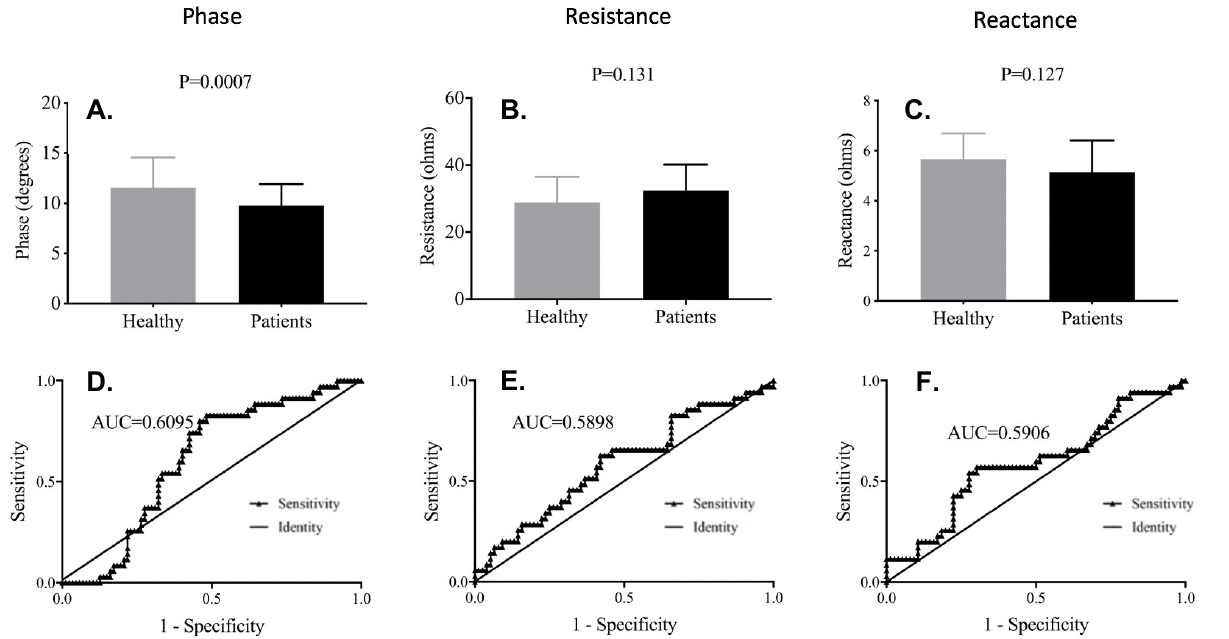
Figure 3. A, B, C. The phase, resistance, and reactance values at 100 kHz ( ± standard deviation) for low back pain patients versus healthy controls. D, E, F. Receiver operating characteristic (ROC) plots for these same values. While the population means may be different, this analytical approach has limited value in discriminating between LBP patients and healthy individuals.